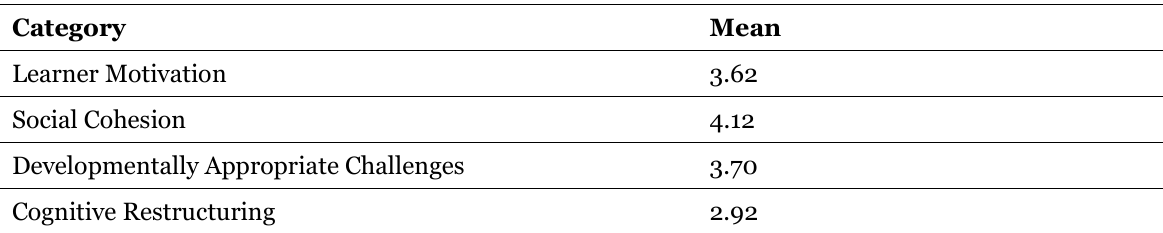
Table 1. Alignment with Slavin’s model of cooperative